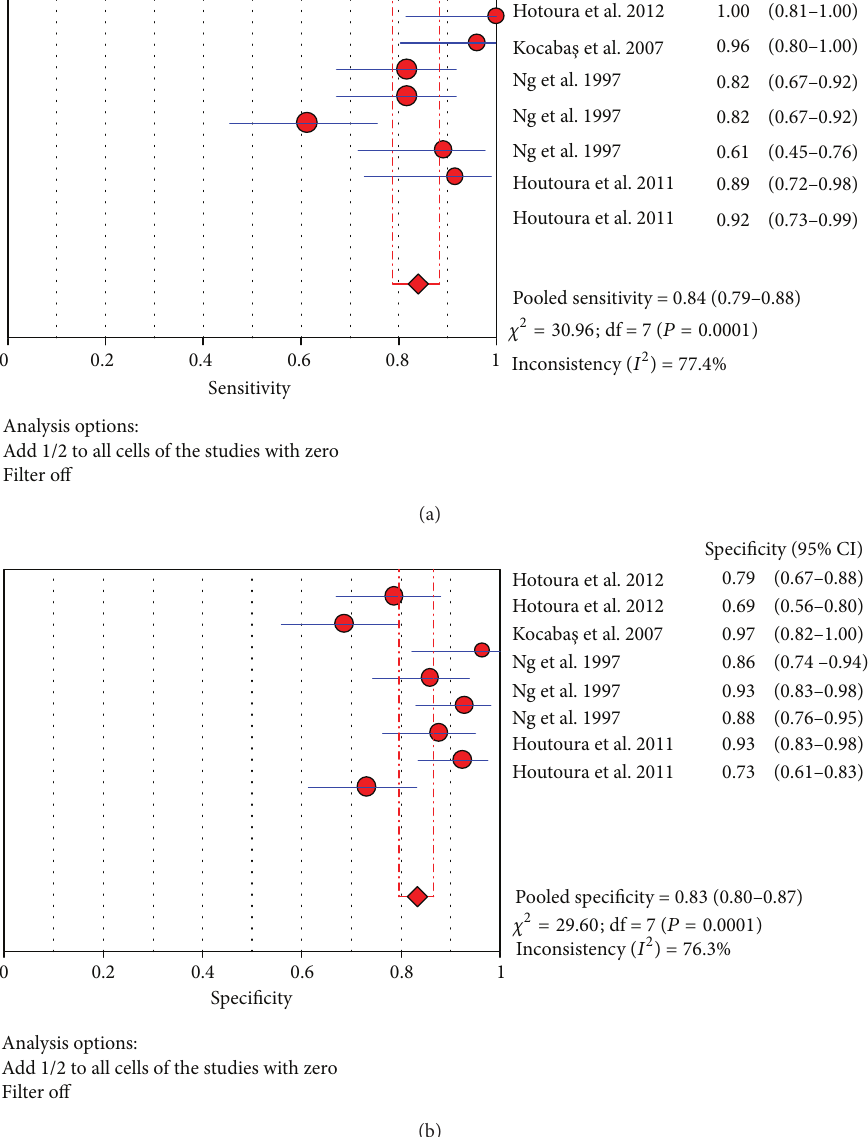
Furthermore, the pooled diagnostic OR for the TNF- 𝛼 was higher than CRP and PCT (37.4 (95% CI 19.1–73.5) versus 8.6 (95% CI 3.5–21.0) versus 11.6 (95% CI 5.2–26.0)). The 𝑄 ∗ value was slightly higher for the TNF- 𝛼 than CRP and PCT (0.87 versus 0.75 versus 0.77). In SROC curve the TNF- 𝛼 ’s AUC is almost equal to CRP (0.93 versus 0.96). As many articles reported that PCT and CRP are good markers, the TNF- 𝛼 is also a good marker for the diagnosis of NS in